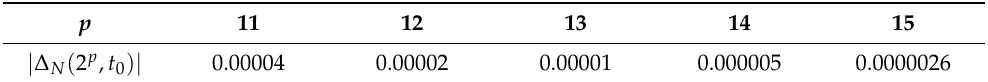
Table A1. Deviations in the uniform N = 2 p approximations for increasing p . Note that values higher than p = 15 could not be checked with the PC at hand.